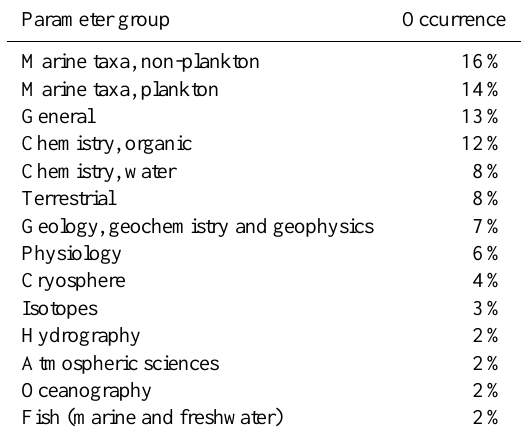
Table 1. Occurrence of different PANGAEA parameter groups used for classifying the IPY data sets.